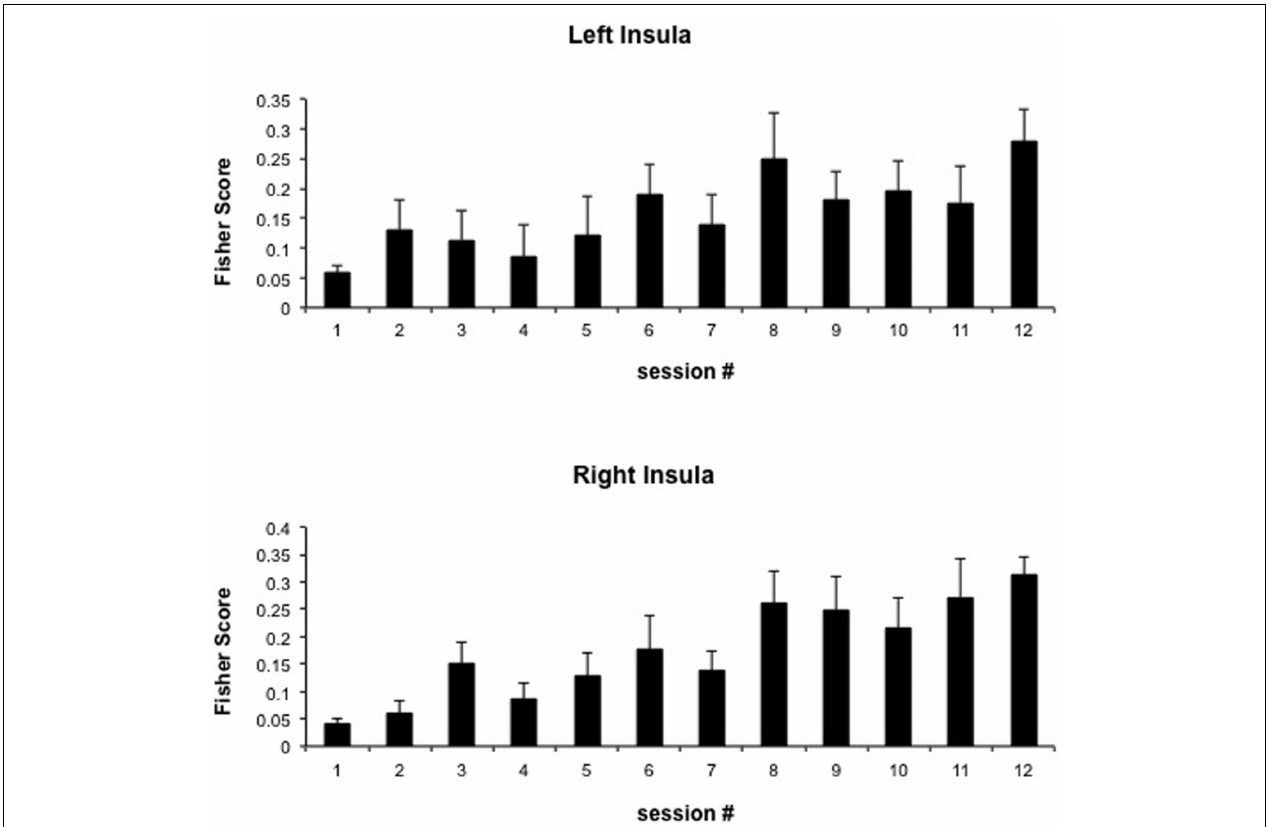
is a measure of signal change that considers both the variance and the mean of the BOLD signal values extracted from the ROIs adapted with permission from Ruiz et al. (2013).